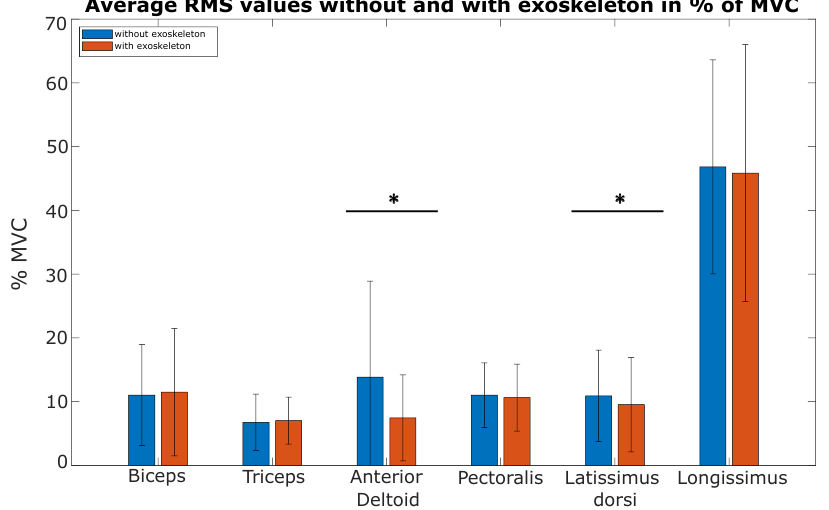
Figure 3. Comparison of mean RMS values between the two conditions (with and without exoskele- ton) in pourcentage of MVC. Significant differences ( p -value < 0.05) denoted by *.